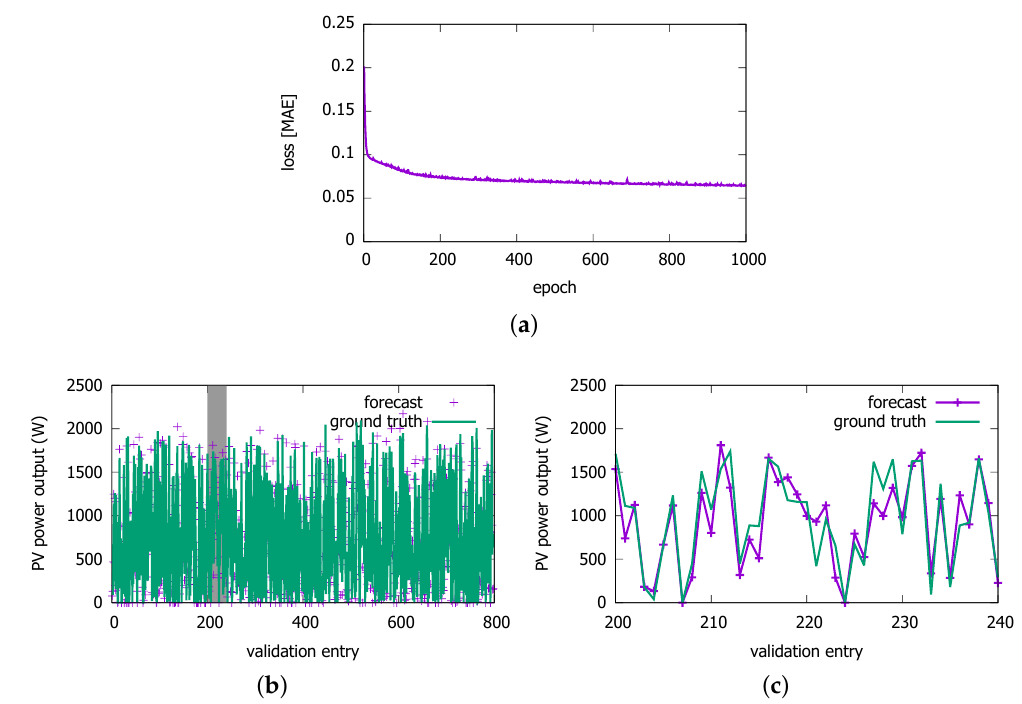
Figure 12. A PV power output learning result for 2016 data set. ( a ) loss against training data set; ( b ) prediction results against validation data set; ( c ) detailed prediction results on validation data set (shaded band in ( b